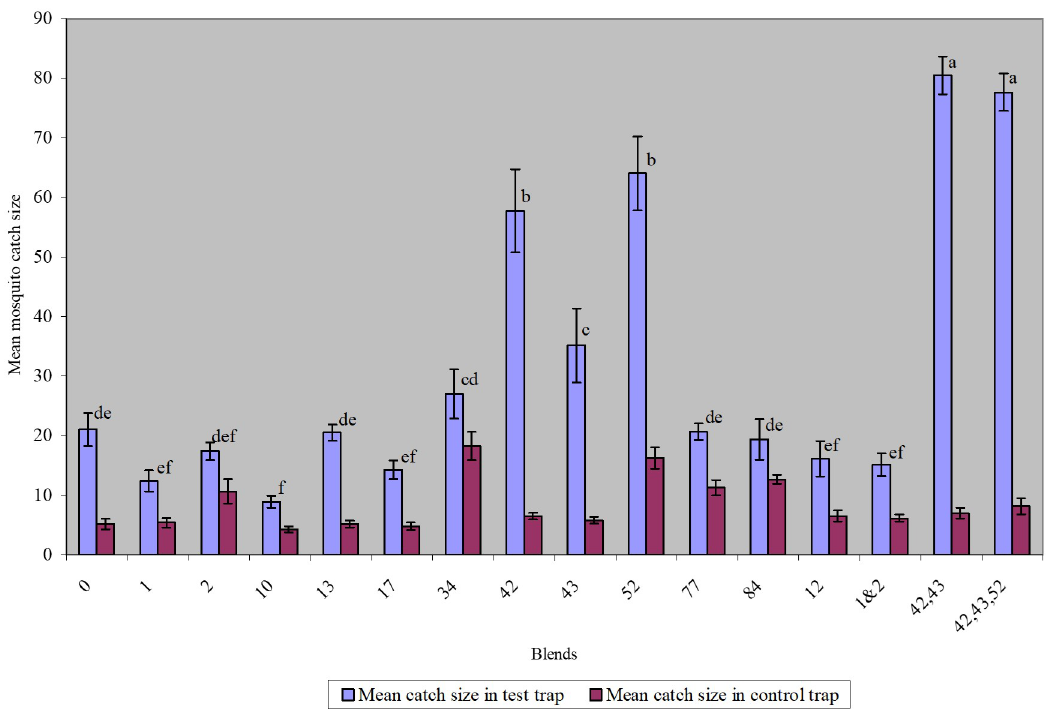
Fig 6. Comparison of mean mosquito catch sizes � in test and control CFG traps. � Based on 8 replicates of mosquito catch sizes per blend; blends not sharing the same letters are significantly different (p = 0.0001).